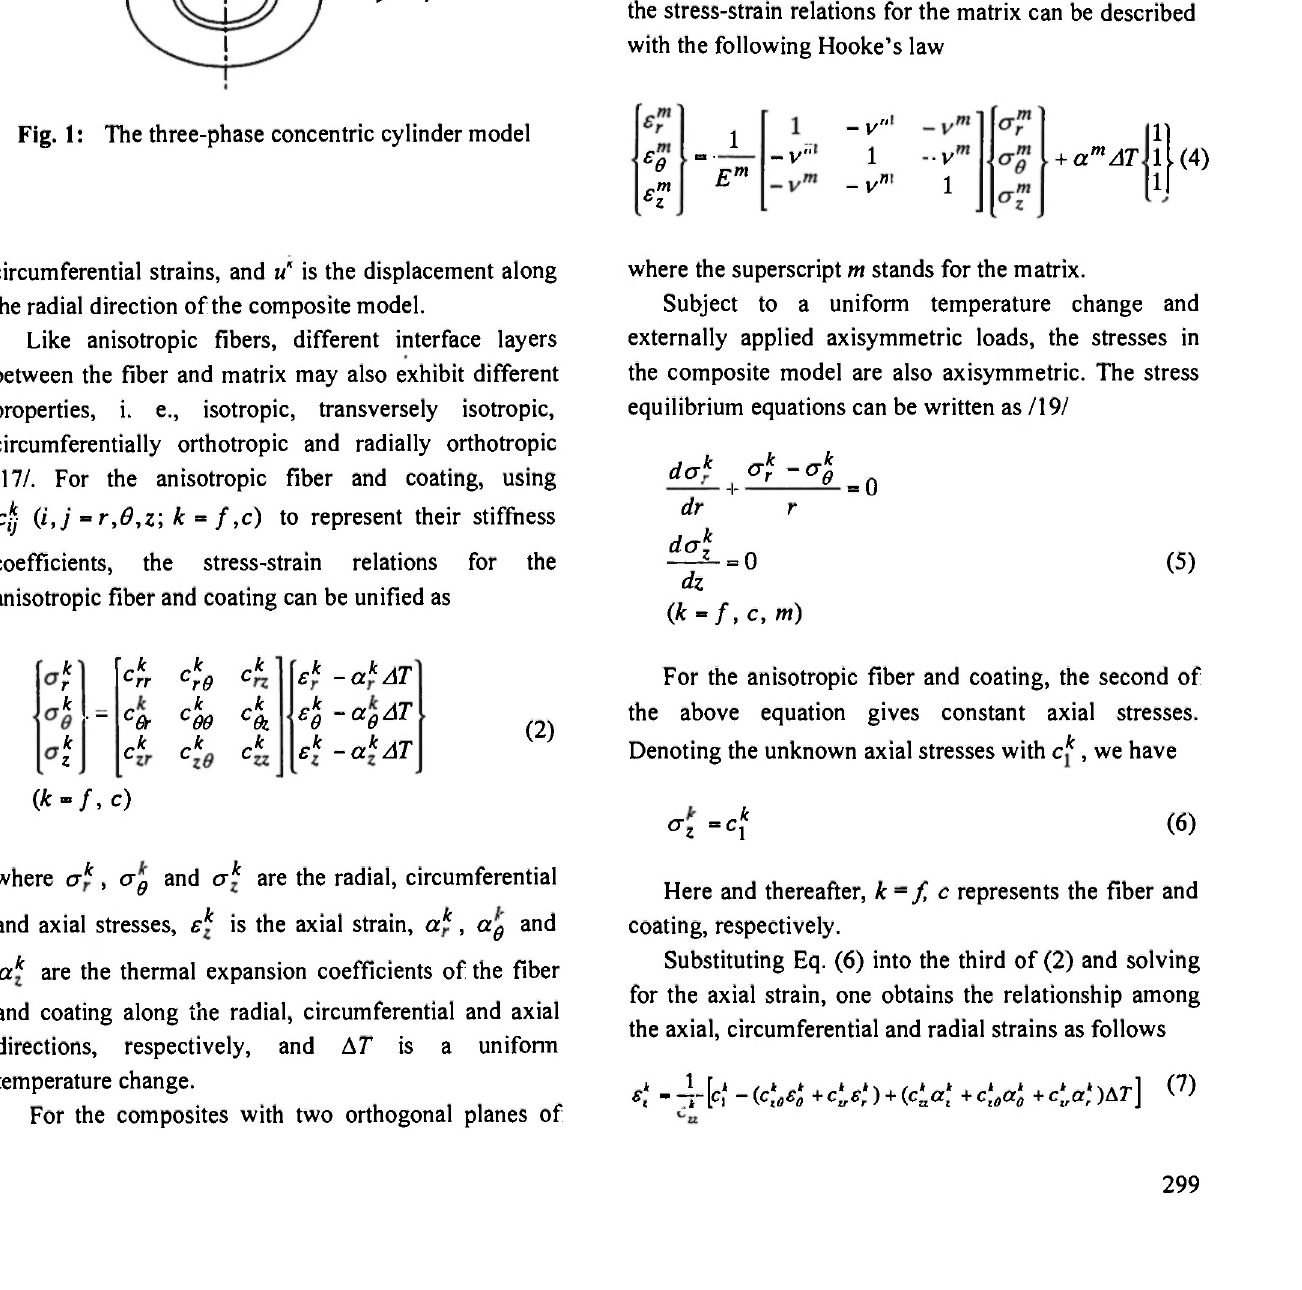
Using E"' and v m to represent Young's modulus and Poisson's ratio of the isotropic matrix, respectively, r the stress-strain relations for the matrix can be